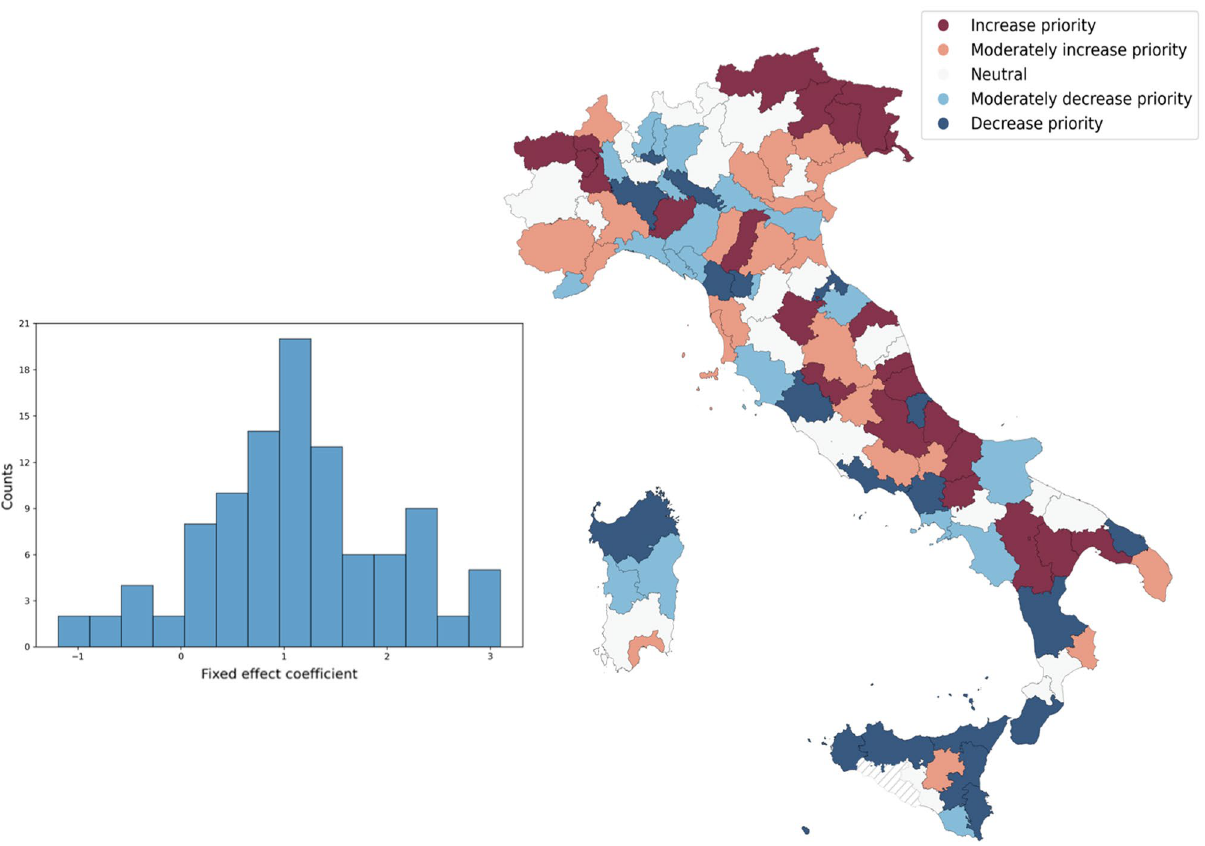
Figure 3. Left panel: Histogram of the Fixed effect values for WGF in the different Italian provinces (NUTS-3 regions); Right panel: Adjusted prioritization policy according to the ranking difference between WGF fixed effects and number of